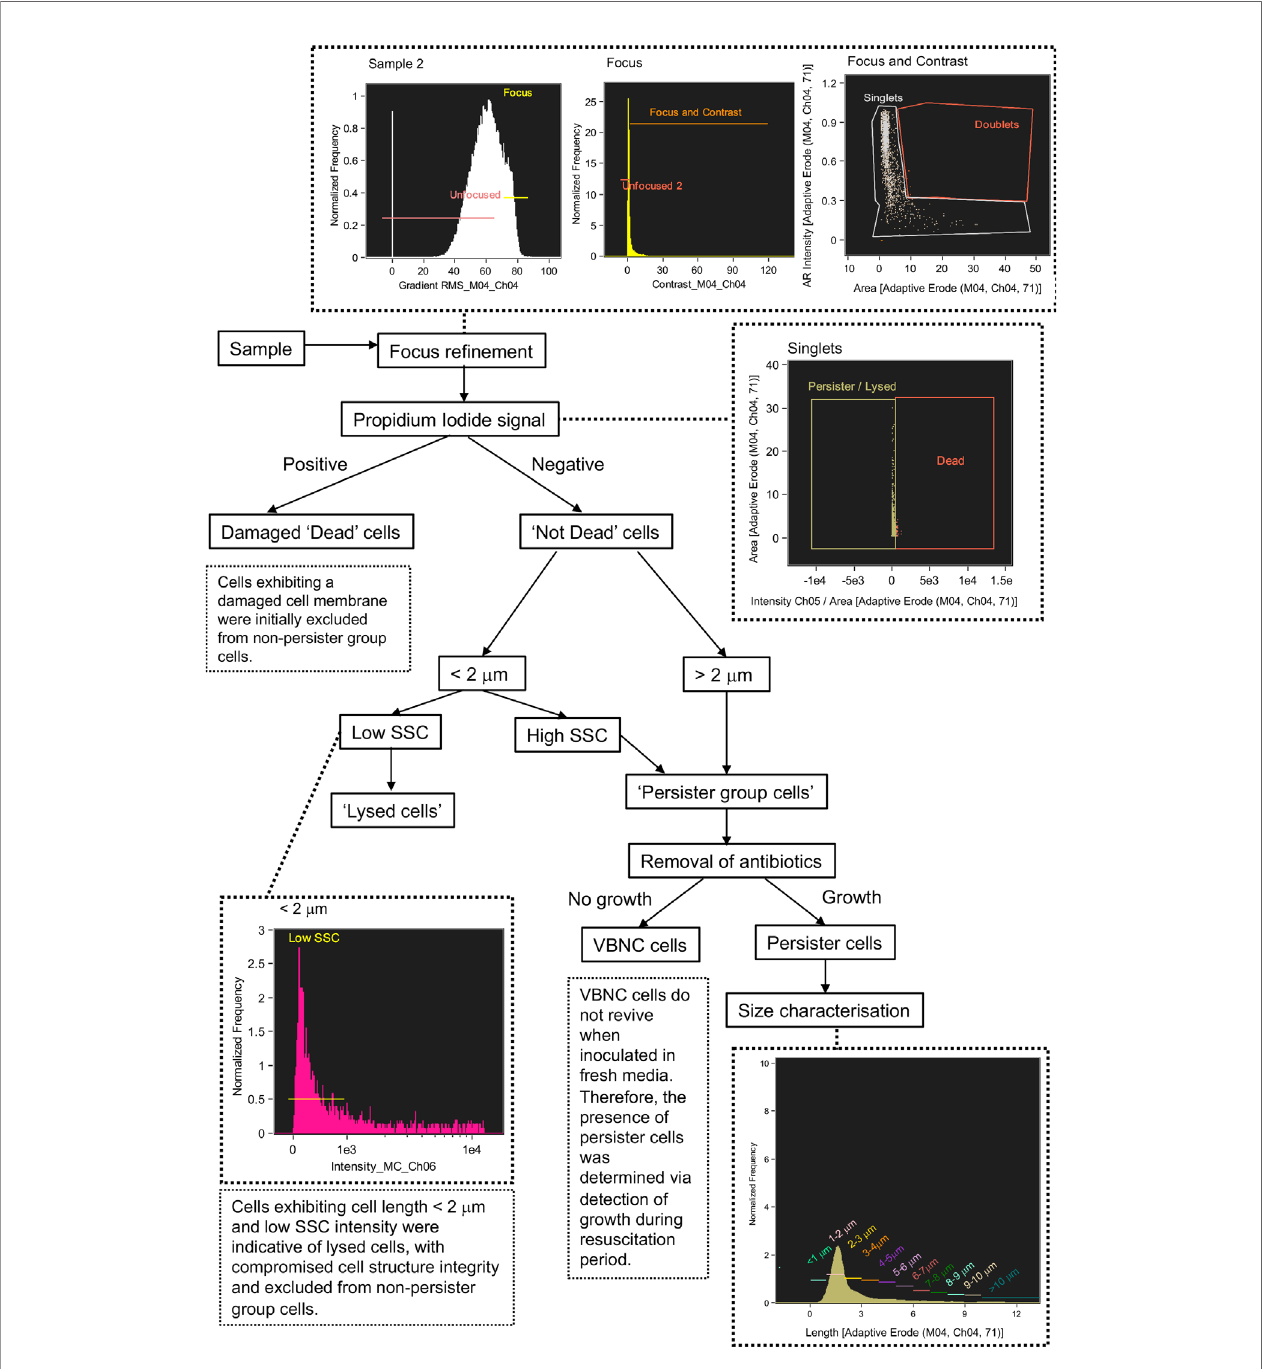
FIGURE 5 | Flow diagram of steps taken to discriminate between lysed cells, damaged cells, viable but non culturable cells and persister cells using Imaging Flow